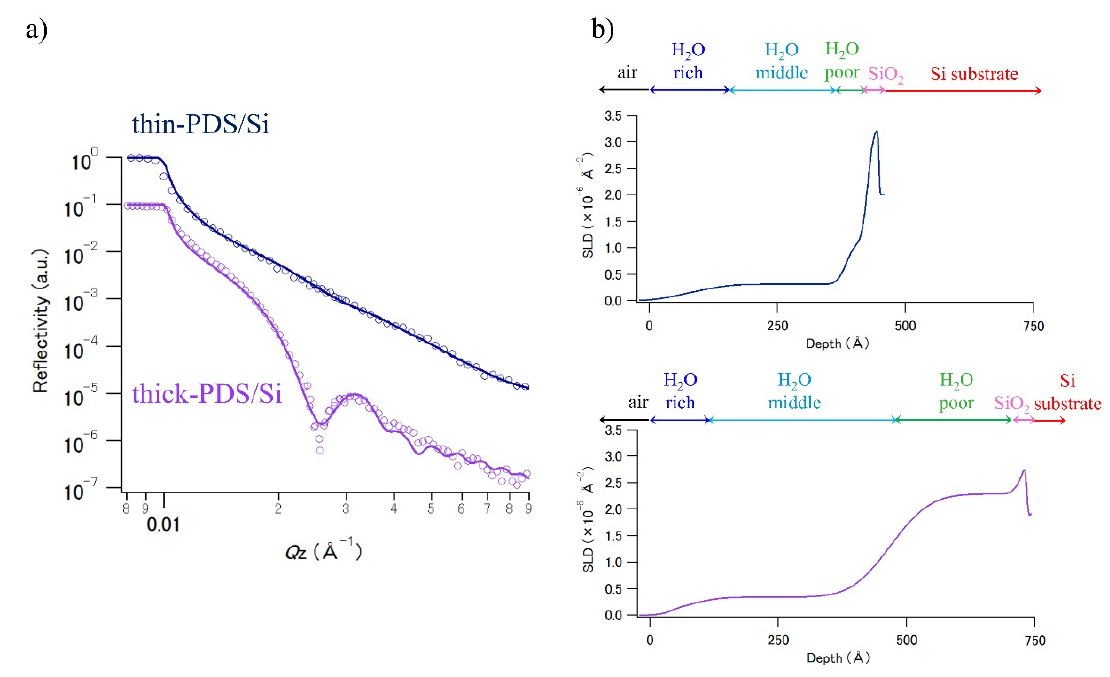
Figure 5. ( a ) Neutron reflectivity profiles of the thin and thick PDS layer samples in wet condition. The circles represent the experimental data, and the solid lines represent the best ‐ fit calculated NR profiles. ( b ) Depth profiles of the PDS layer samples calculated by obtained structural parameters. Table 2. Best ‐ fit parameters for the reflectivity model data shown in Figures 5.